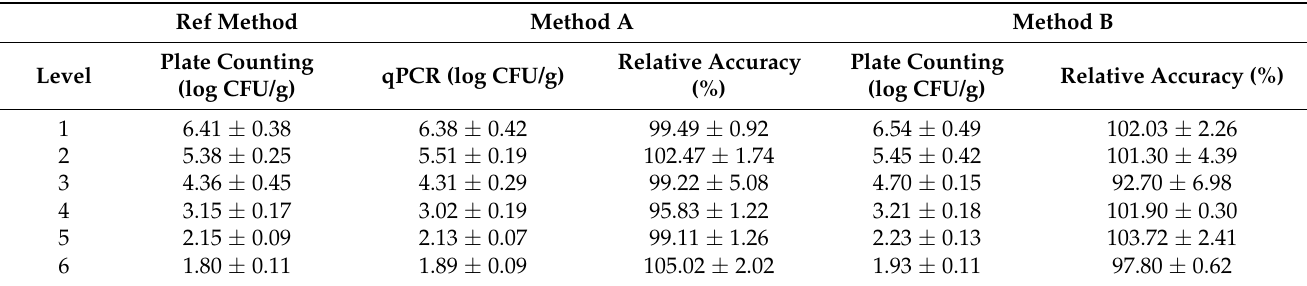
Table 4. Bacterial concentration ( ± sd) and relative accuracy ( ± sd) of methods A and B regarding ISO 11290-2 for the quantification of L. monocytogenes in cured ham